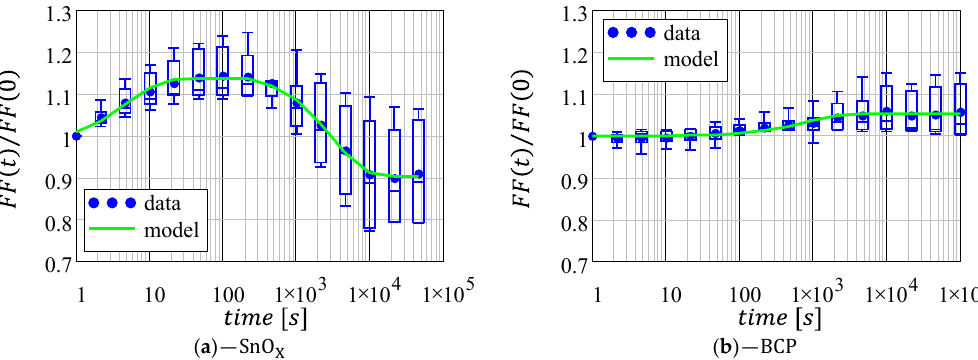
Figure 5. Normalized fill ‐ factor as a function of time for the two architectures under analysis: ( a ) SnO X -based cells; ( b ) BCP-based cells. Data fitting (green line) was computed using the mean values (blue circles) as a data-set. Plots are reported with the same axis for a direct comparison. Full-scale axes are reported in Supplementary Figure S4.